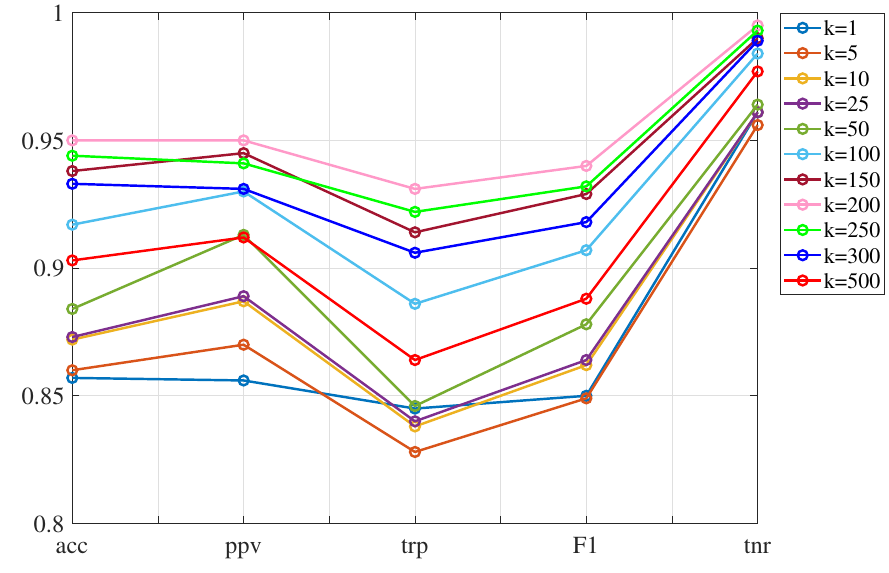
Figure 10. Indicators corresponding to the k -NN method using 90% of variance. The case k = 200, represented by the pink line, shows the best performance in each of the evaluation